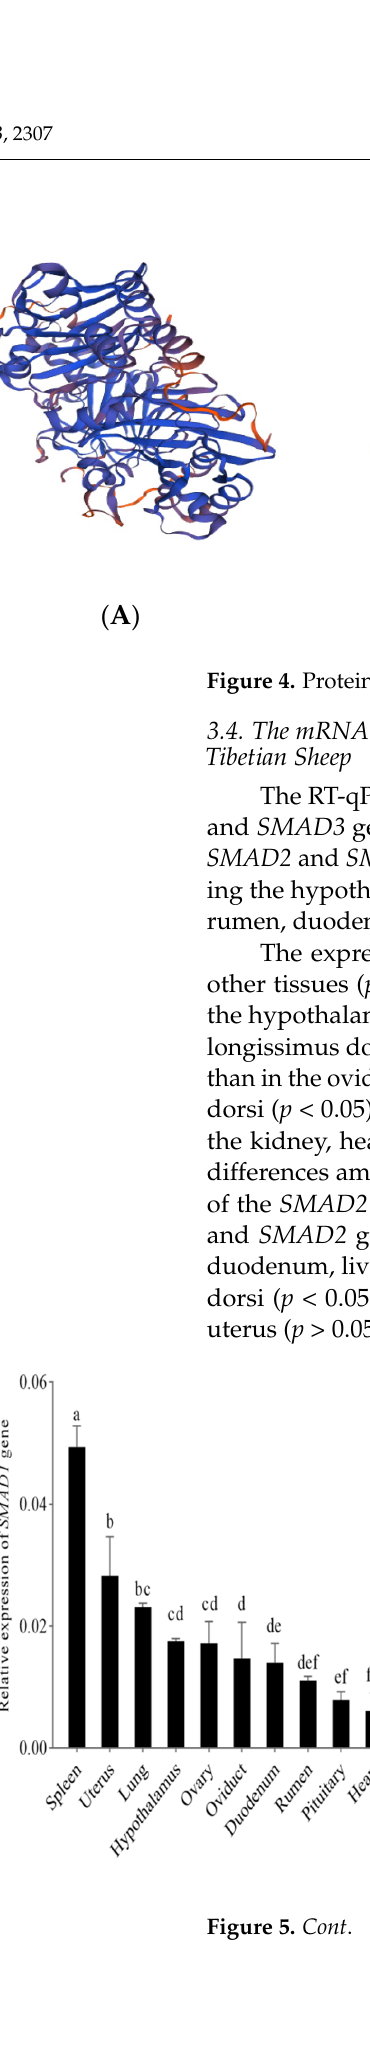
Figure 3. Protein s econdary structure of SMAD1 ( A ), SMAD2 ( B ) and SMAD3 ( C ) in Tibetan sheep. The α helix is in blue, the β turn is in green, the random coil is in yellow, and the extended strand is in red.